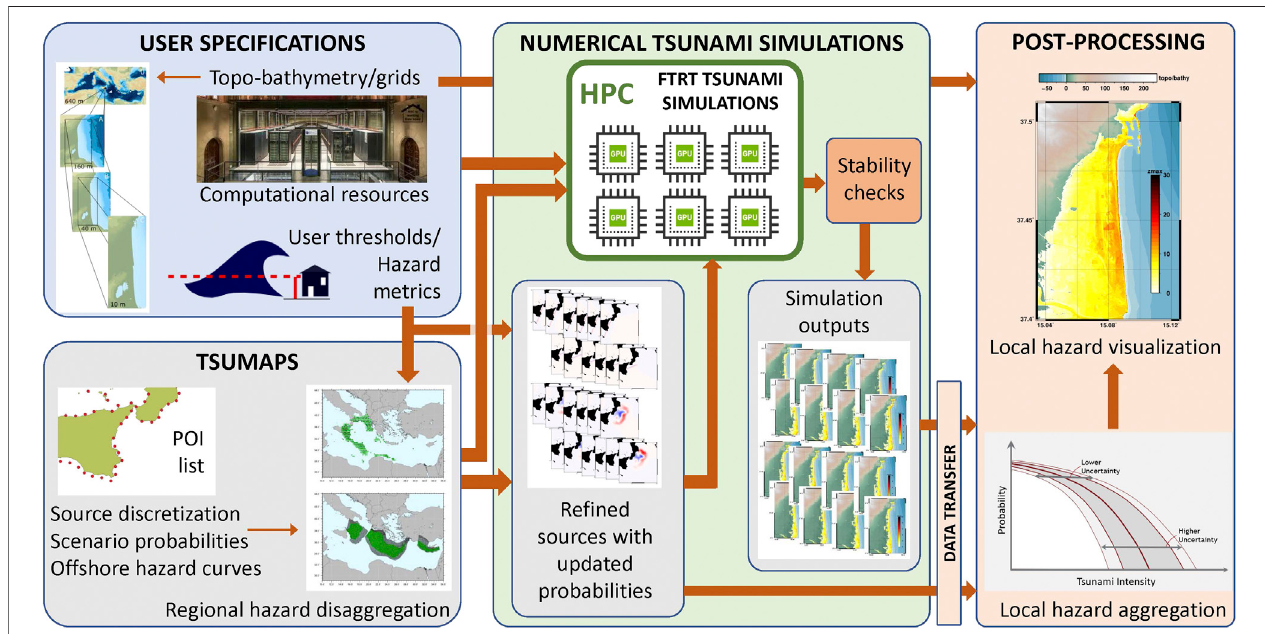
FIGURE 1 | Overview of the Probabilistic Tsunami Hazard Analysis (PTHA) work fl ow. The step involving HPC resources is shown in the green box. Preprocessing and hazardaggregation isperformed outside theHPC system.As large amounts ofdatacan beproduced,attention ispaid tocontinuousdatatransferduring the entire HPC